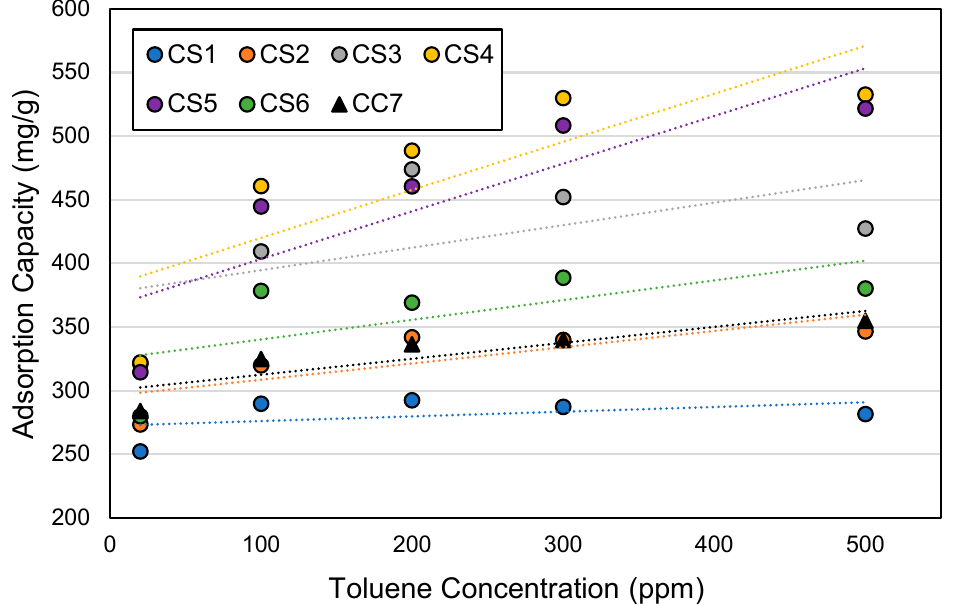
Figure 9. Adsorption capacity by toluene concentration and cartridge type. Cartridge type (ACF composition): CS1 (100% AF1); CS2 (100% AF2); CS3 (100% AF3); CS4 (100% AF4); CS5 (100% AF5); CS6 (100% AF6); CC7 (71% AF1/29% AC1).